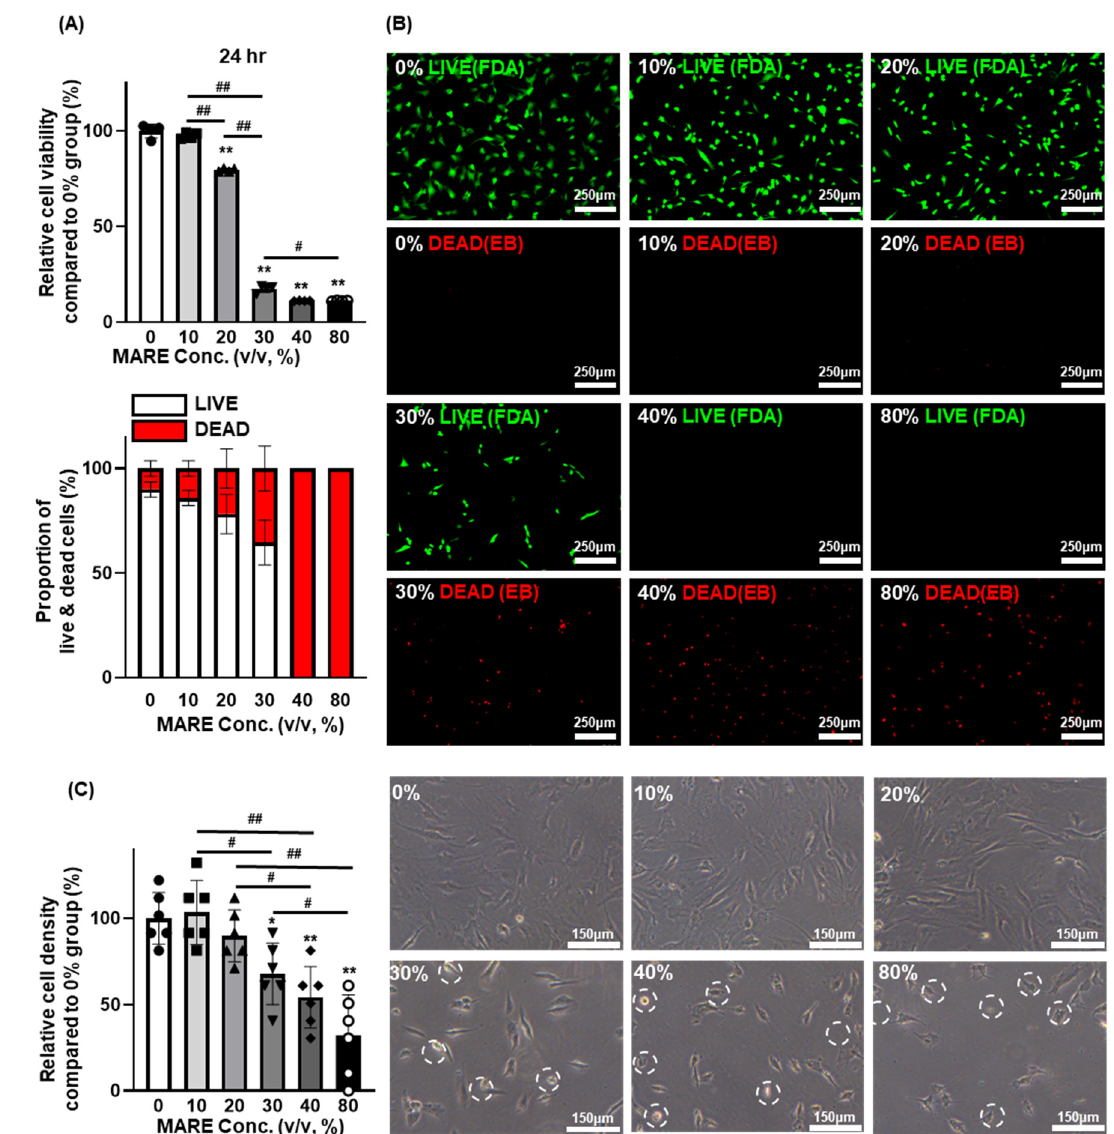
Figure 2. Optimized MARE concentration for hair follicle dermal papilla cells (HFDPCs) in terms of cell viability. ( A ) Cell counting kit-8 (CCK-8) assay results of MARE-treated HFDPCs (24 h, n = 4, upper panel) and quantification of EB-positive cells in unit area compared to the 0% group ( n = 6, lower panel). * p < 0.05, ** p < 0.001 compared to the 0% group, # p < 0.05, ## p < 0.001 compared to each other. ( B ) Live (fluorescein diacetate (FDA), green) and dead (ethidium bromide (EB), red) assay results of MARE-treated HFDPCs. ( C ) Relative cell density of HFDPCs ( n = 6, left panel) and light microscopy images showing cell morphology (right panel) of the HFDPCs after MARE treatment with various concentrations (100 × ). * p < 0.05, ** p < 0.001 compared to the 0% group, # p < 0.05, ## p < 0.001 compared to each